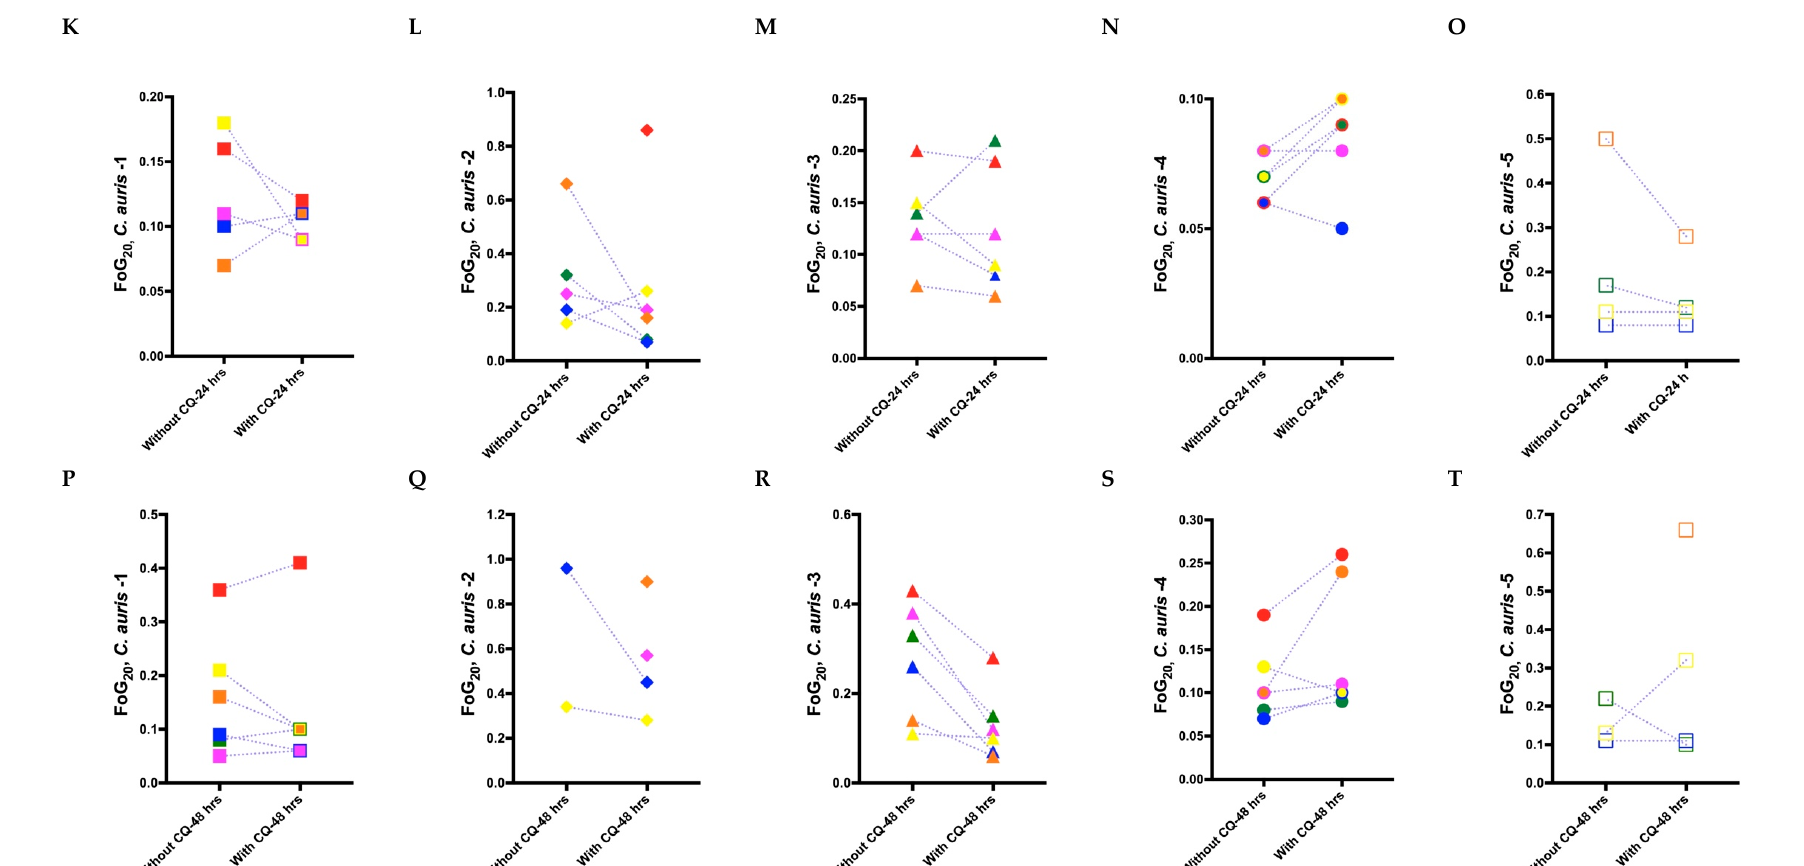
Figure 5. Radius of the zone of inhibition (RAD) and fraction of growth in the zone of inhibition (FoG 20 ) measurements for C. auris isolates for adjuvant antifungal disk diffusion assays. ( A – E ) Mean RAD measured for the C. auris isolates at 24 h against antifungal drugs with and without the adjuvant chloroquine. ( F – J ) Mean RAD measured for the C. auris isolate at 48 h against antifungal drugs with and without chloroquine. ( K – O ) Mean FoG 20 measured using diskImageR [29] for all C. auris isolates at 24 h against antifungal drugs with and without chloroquine. ( P – T ) Mean FoG 20 measured using diskImageR for the C. auris isolates at 48 h against antifungal drugs with and without chloroquine. Note that the single data points in ( L ), ( Q ), and ( T ) at 48 h are due to the mitigation of resistance in presence of chloroquine, as FoG 20 could not be measured for these isolates at 24 h because of their resistance to the corresponding antifungal